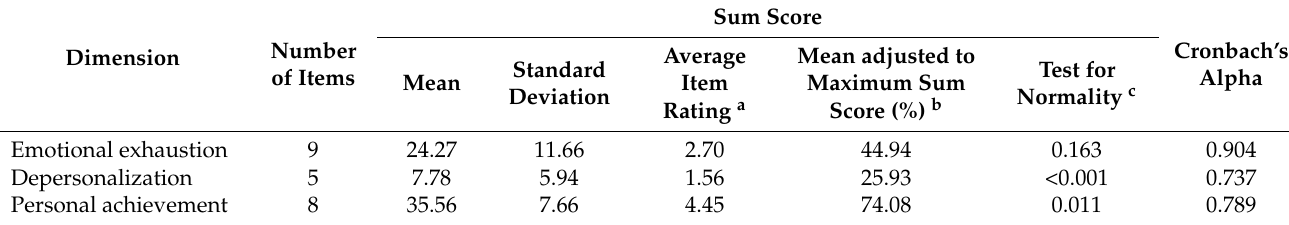
Table 4. Statistical and psychometric characteristics of the Maslach Burnout Inventory dimensions ( n = 380).